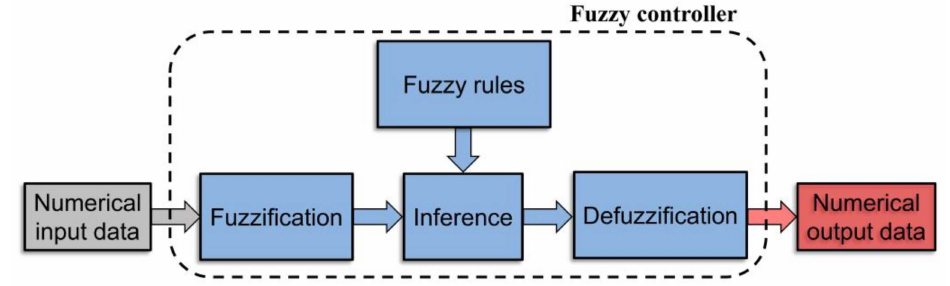
Figure 7. A schematic representation of a fuzzy logic